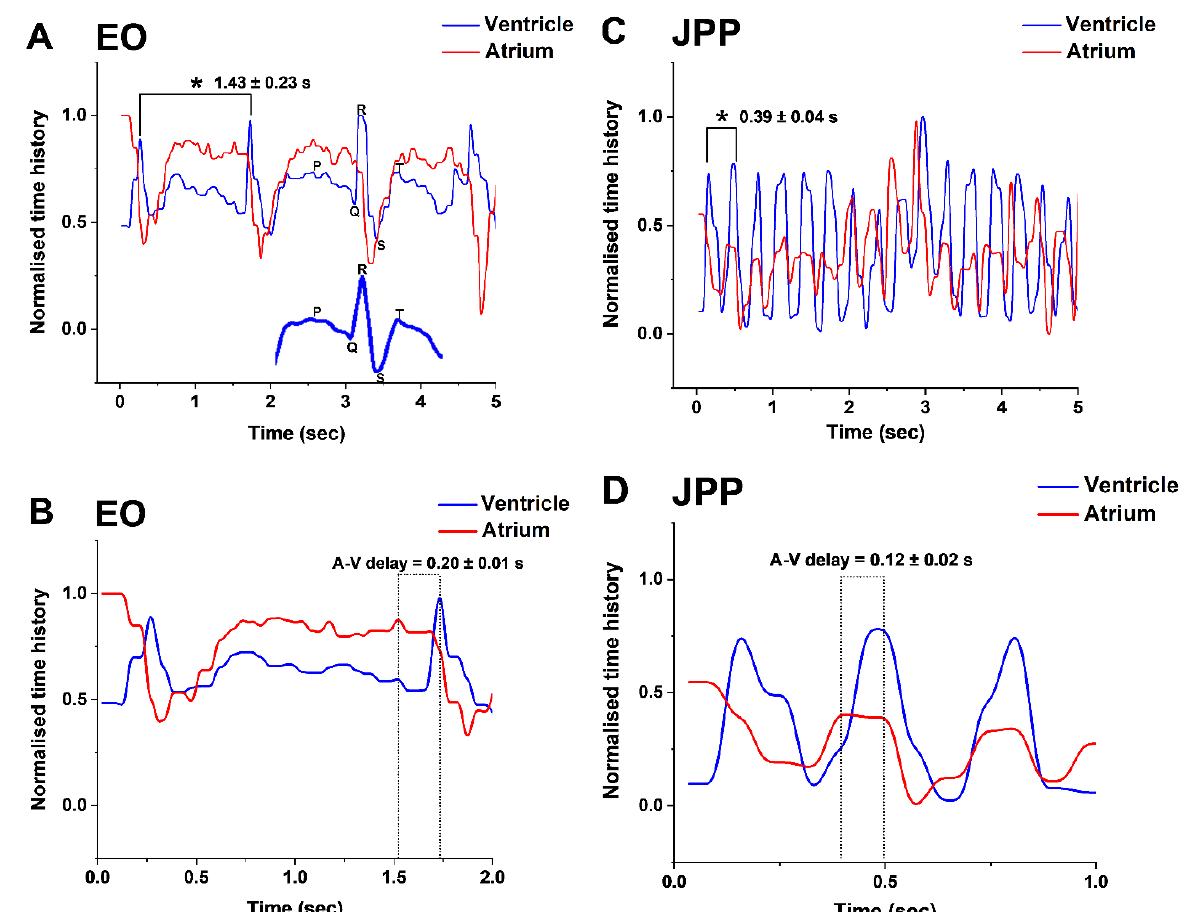
Figure 7. Light-cardiograms (LCGs) representing synchronicity of contractions and relaxations of cardiac compartments at early organogenesis (EO) and JPP of G. holbrooki . The chronograms ( A , C ) represent normalised ventricle and atrium time history contractions over 5 s at EO and JPP stages, respectively. Smoothed partial LCG corresponding to synchronous ventricular and atrial contractions resembling a typical ECG (P-wave, QRS-complex, and T-wave) chronograms is presented (A inset). The complete cardiac cycle, i.e., the time interval between two consecutive ventricular peaks, is marked with an asterisk. ( B , D ) are magnified view of ( A , C ) respectively showing time delay (dashed boxes) between atrium and ventricle beats (i.e., A-V delay).